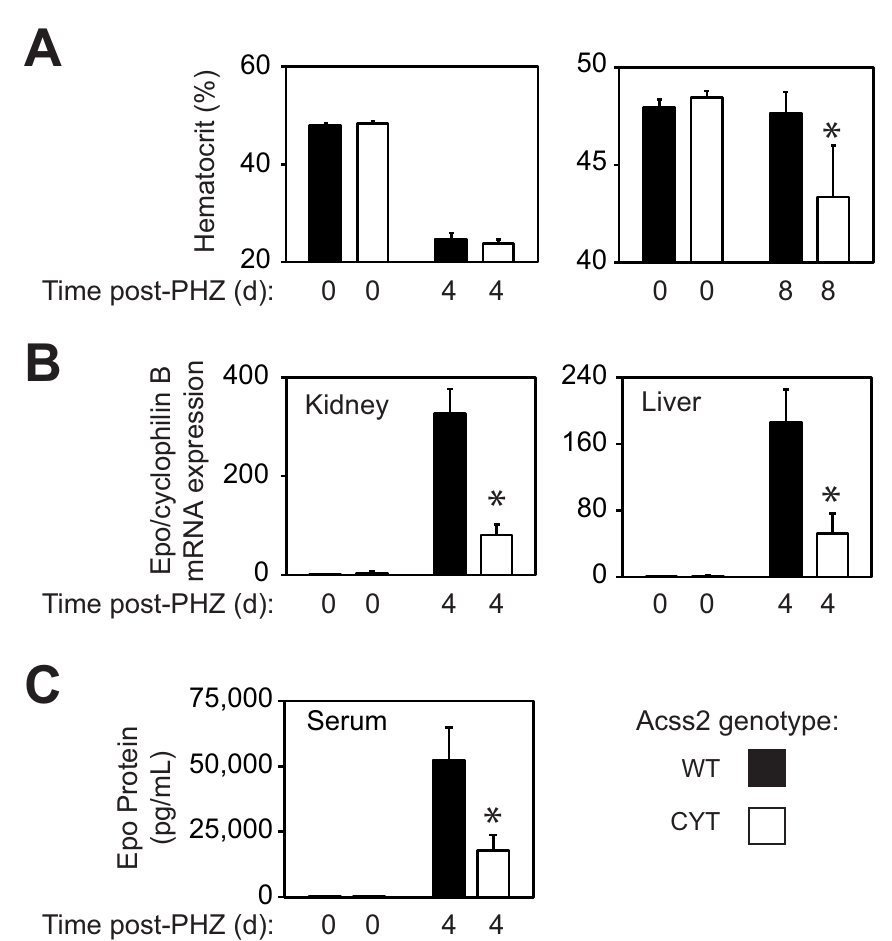
Fig 2. ED Acss2 mice have impaired physiological and molecular responses. (A) WT and ED mice have similar baseline hematocrit levels. Following phenylhydrazine (PHZ) exposure, WT and ED mice were selected for a comparable degree of anemia. At 8 days following PHZ exposure, ED mice had a blunted recovery in hematocrit levels relative to WT mice (mean with SEM, n = 7 mice per group, �� P = 0.08). (B) Induction of the HIF-2 target gene erythropoietin (Epo) is impaired in kidney (mean with SEM, n = 8 mice per group, � P = 0.018) and liver (mean with SEM, n = 8 mice per group, � P = 0.013) of anemic ED mice versus WT mice at 4 days following PHZ exposure. (C) Serum Epo protein levels are also reduced in ED mice relative to WT mice (mean with SEM, n = 8 mice per group, � P = 0.017).